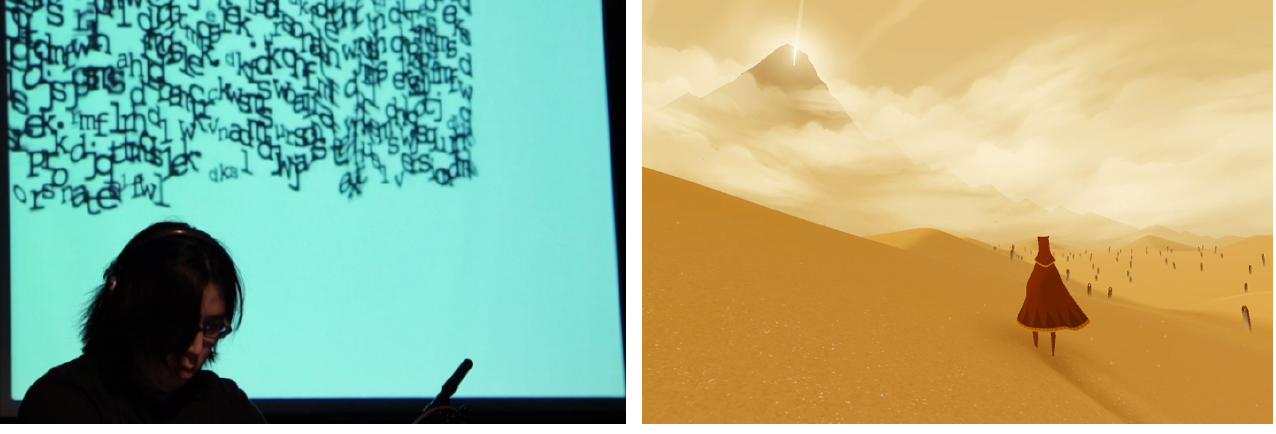
(a) Live Writing: Gloomy Streets [72, p. 1389]. (b) Journey [90] (PlayStation Europe, CC BY-NC 2.0). Figure 1: Visual dialogue genre